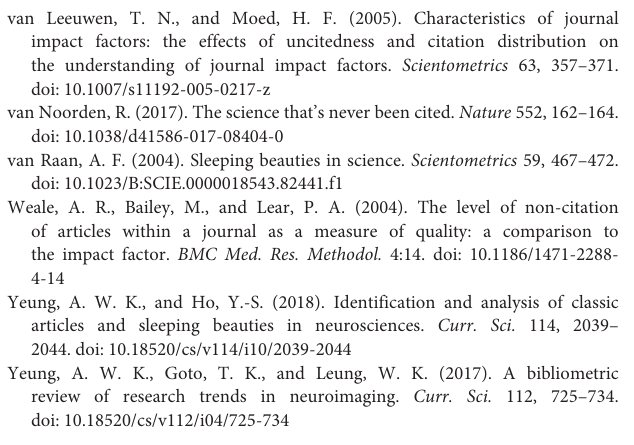
FIGURE S1 | Scatter plot of log-10 impact factor 2017 against percentage of uncited citable